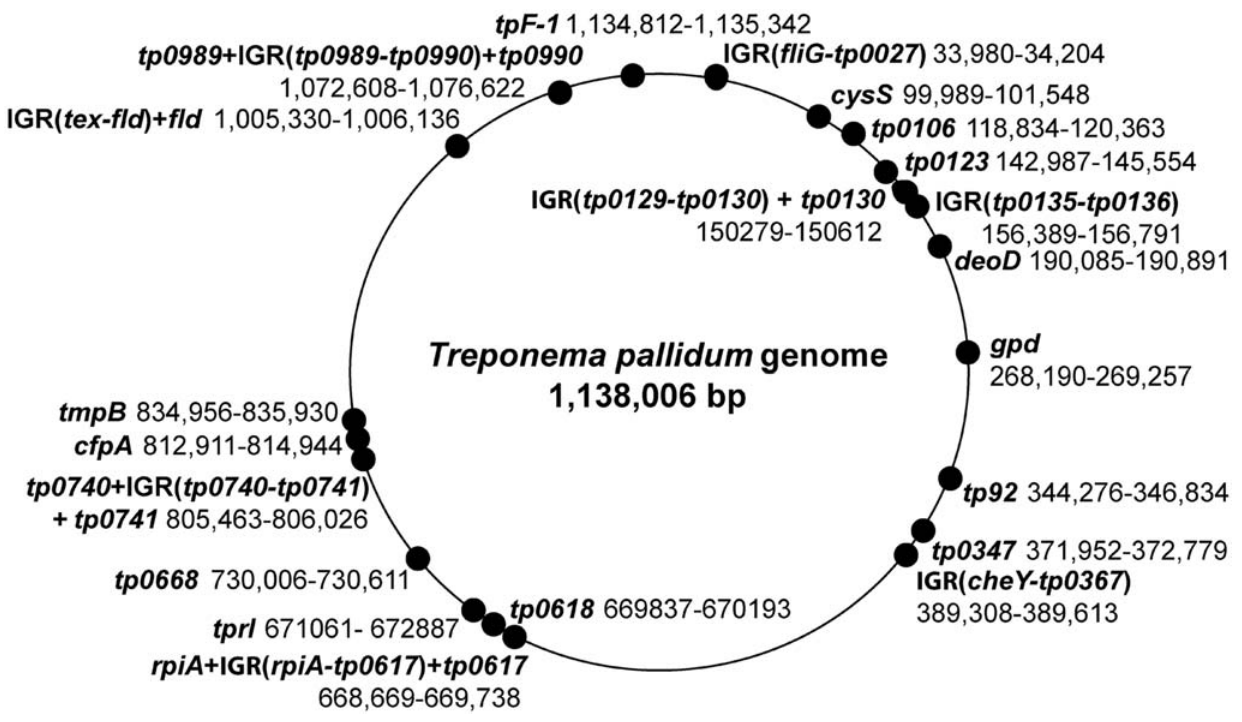
Figure 1. Genome coordinates of the 21 regions targeted for sequencing. The name of the genes and/or intergenic regions (IGRs) amplified are shown in bold next to their numeric coordinates and a point denoting their location in the genome. The coordinates of the nucleotides sequenced within each gene/IGR can be found in Table 2.